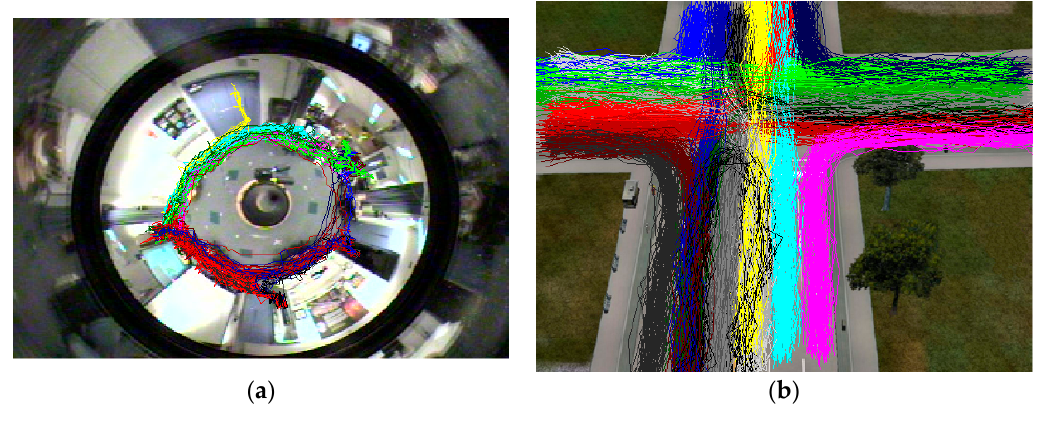
Figure 9. Labomni dataset ( a ) and Cross dataset ( b ).